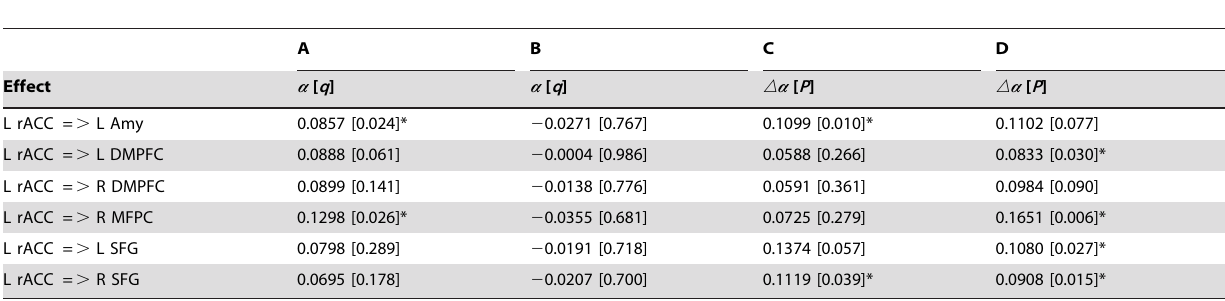
The table contains meta-analytic group values of the VAR path coefficients ( a ) with the corresponding FDR q -values (in square brackets), as well as group differences in the path coefficients ( n a ) with the corresponding uncorrected P -values. The four data columns (A,B,C,D) correspond to the four subplots (A,B,C,D) in Fig. 3. *indicate significant effect.